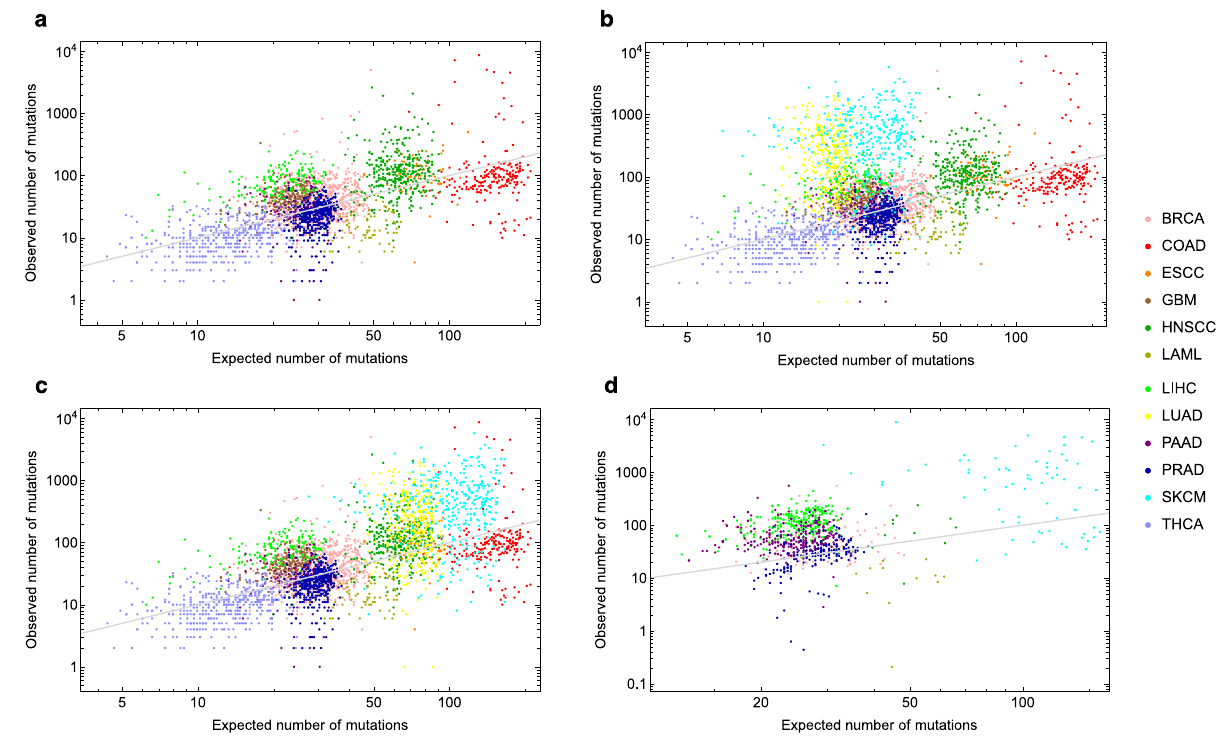
Fig. 1 | Predicted versus observed number of mutations. Observed number of somatic mutations found in: a – c 3608 cancers, for 12 types of cancer (TCGA database), d 990 cancers, for 7 types of cancer (ICGC database), versus the cor- responding expected number of mutations as predicted by our model (2) for a cancer patient of the same age: a – b solely due to the endogenous mutational processes, c – d including the effect of tobacco smoking (LUAD) and UV light